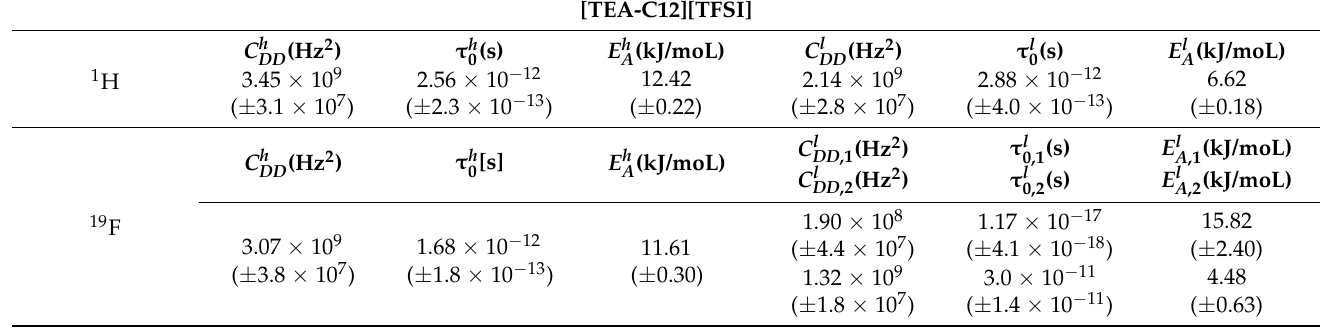
Table 3. Parameters obtained from the analysis of the 1 H and 19 F spin-lattice relaxation data for [TEA-C12][TFSI].